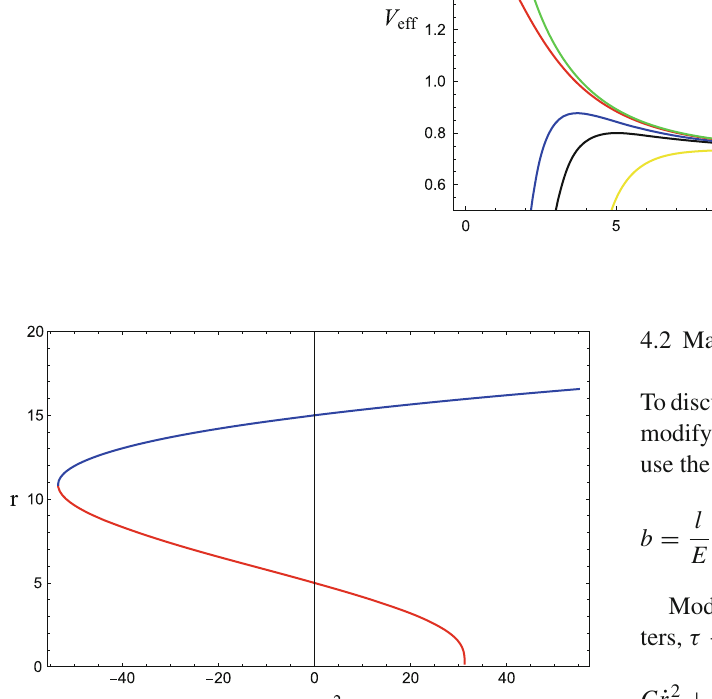
Fig. 4 V ef f with various value of κ/ M 2 ( (cid:19) = 0 . 2 and (cid:21)/ M = 5)